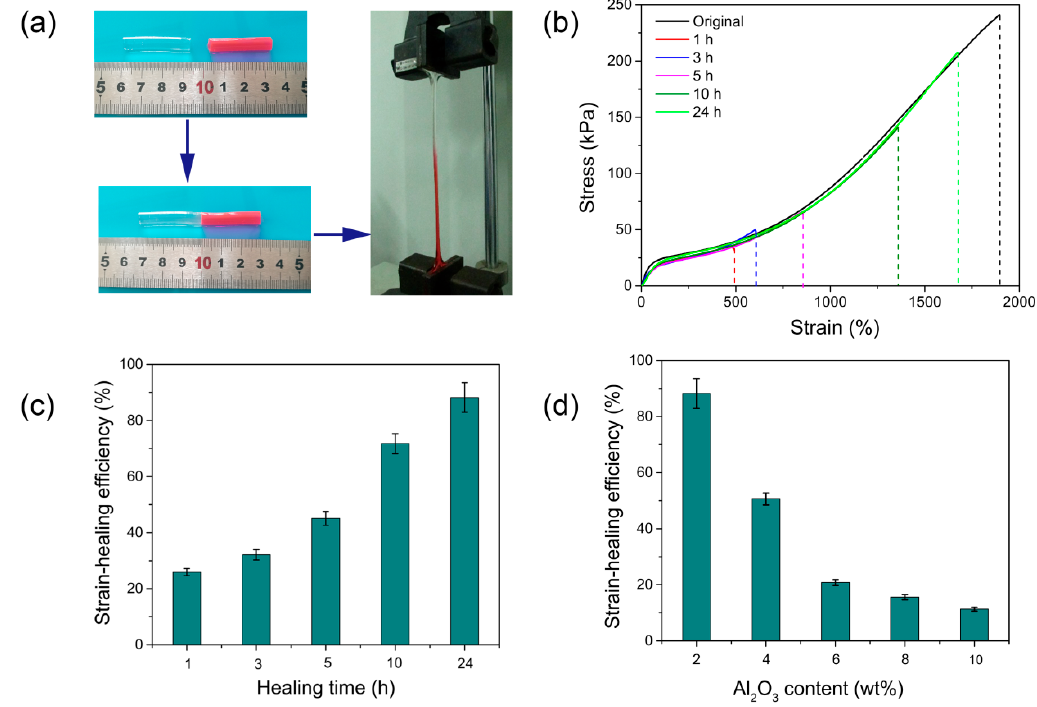
Figure 6. ( a ) Illustration of self-healing capacity of PAS gels; ( b ) stress–strain curves of the original and healed PAS-1 gel; ( c ) self-healing efficiency of PAS-2 gel after healing for different time; ( d ) self-healing efficiency of PAS gels with different Al 2 O 3 content after healing for 24 h.